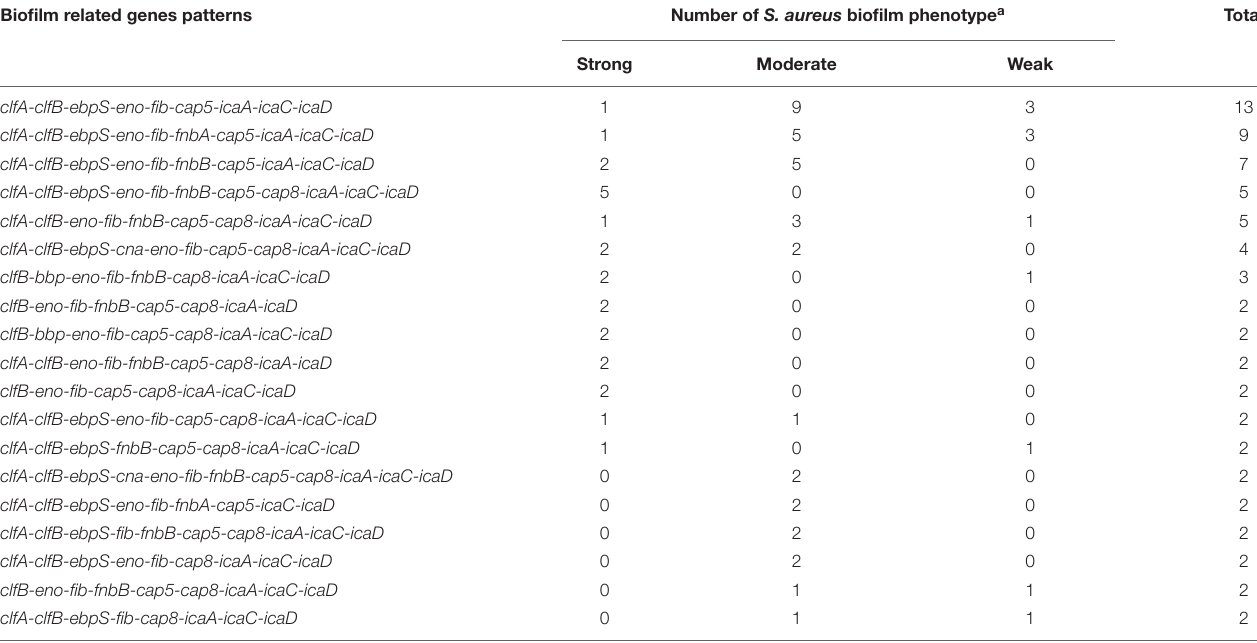
FIGURE 5 | Diagram showing the antibiotic resistance pheno- and agr types, virulence genes profiles and biofilm phenotype of S. aureus isolated from different stages of pork production. The diagram was established on the basis of the presence and absence of selected determinants. For antibiotic resistance phenotype, black indicates resistance, gray indicates intermediate, and white indicates susceptible. CIP, ciprofloxacin; PEN, Penicillin; GEM, gentamicin; TET, tetracycline; CLR, clarithromycin; CHL, chloramphenicol; SXT, trimethoprim-sulfamethoxazole; NIT, nitrofurantoin; RIF, rifampicin; CLI, clindamycin; CEF, cephalothin; MIN, minocycline; OXA, oxacillin; FOX, cefoxitin; For virulence genes profiles, black indicates presence and white indicates absence. For biofilm phenotype, black indicates strong, gray indicates moderate, and white indicates weak. TABLE 5 | The prevalence of biofilm related genes pattern and their associations with biofilm production in 130 S. aureus from different stages of pork production. Biofilm related genes